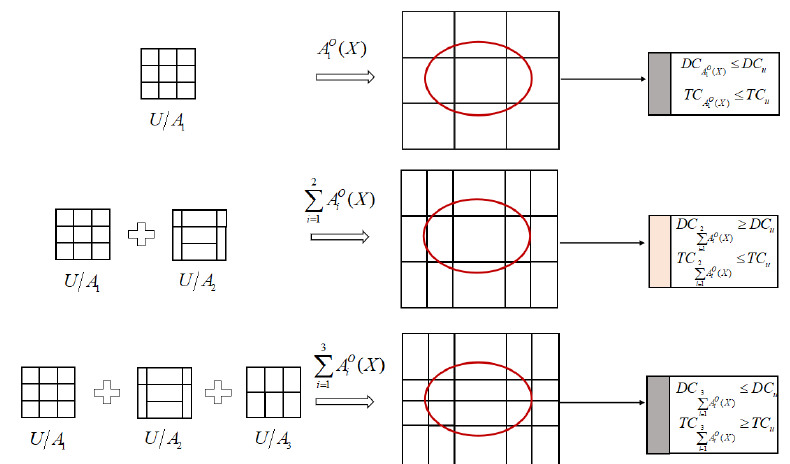
Figure 3. The optimal granularity selection of the optimistic multigranulation approximation. And the red circles in the figure represent the set X .